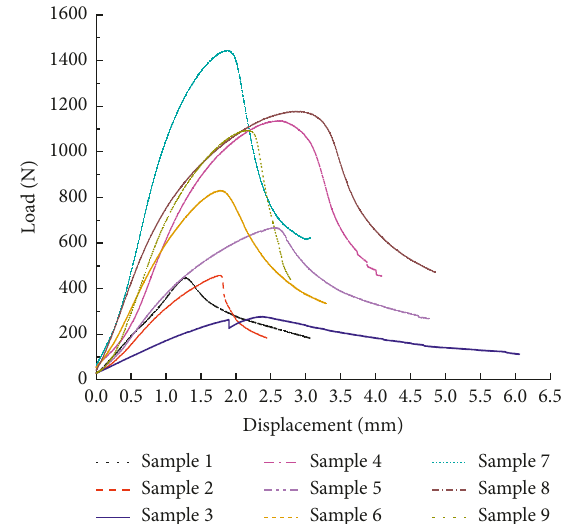
Figure 11: Flat crush force–displacement curves for samples.